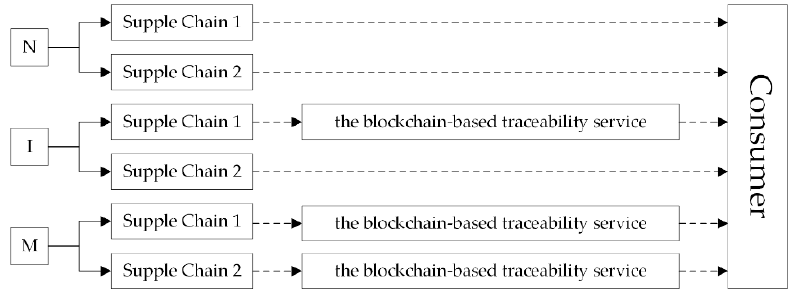
Figure 3. Three Investment situations of the BBTS.